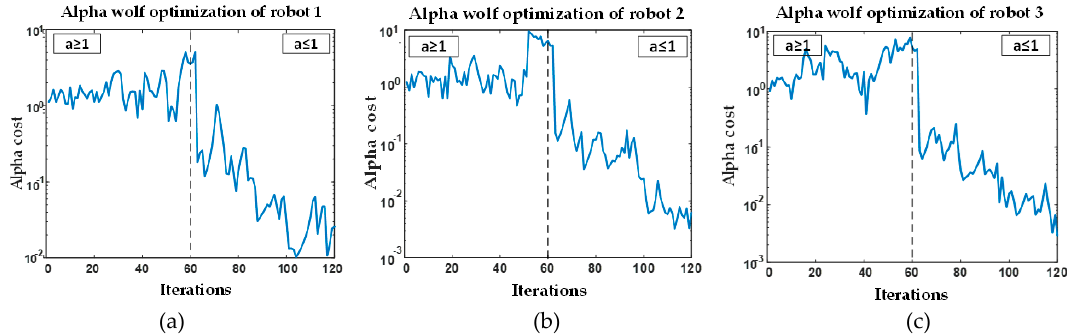
Figure 7. Decision-making process of the alpha solutions: ( a ) robot 1, ( b ) robot 2, and ( c ) robot 3.